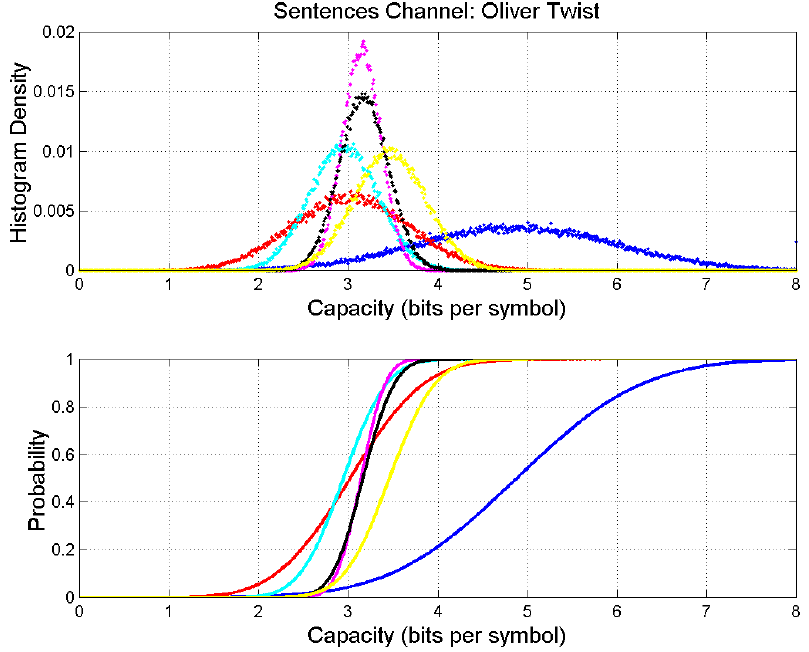
Figure 4. Upper panel : Probability density histograms of self- and cross-channel capacity. The Ad- ventures of Oliver Twist : blue (output); David Copperfield : red; Bleak House : magenta; A Tale of Two Cities ; cyan; Our Mutual Friend : black. Matthew : yellow. Lower panel : Probability distribution functions.